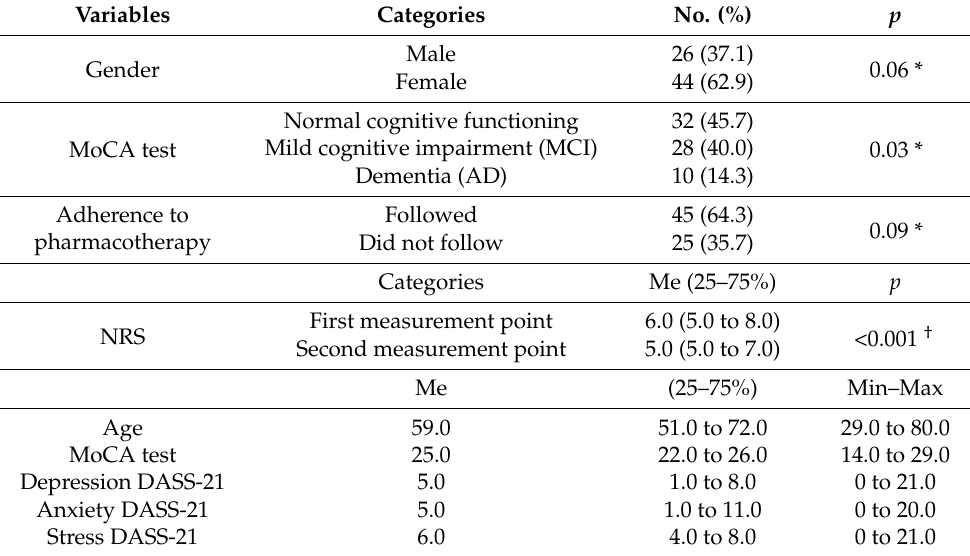
Table 1. Distribution of patients according to demographic characteristics, adherence, MoCA, and DASS-21 scores.